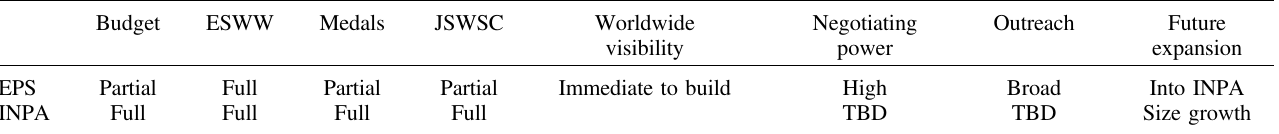
Table 1. Comparison of the control the Space Weather and Space Climate community might have over its resources in the scope of EPS and INPA (TBD = to be